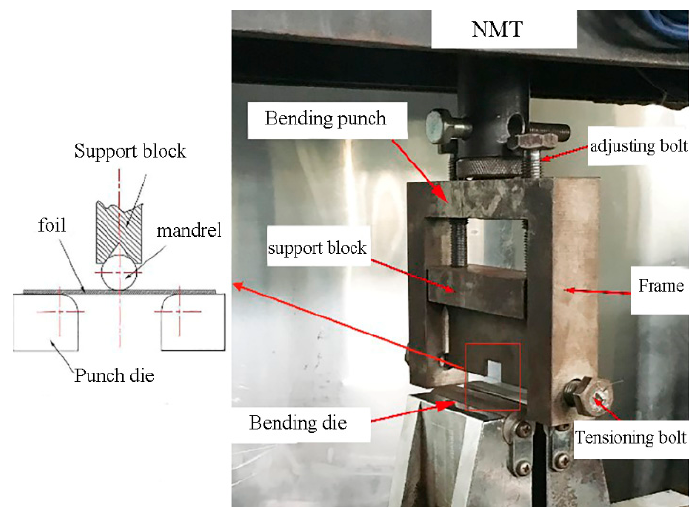
Figure 2. Experimental device of foil bend forming. NMT, material testing machine.